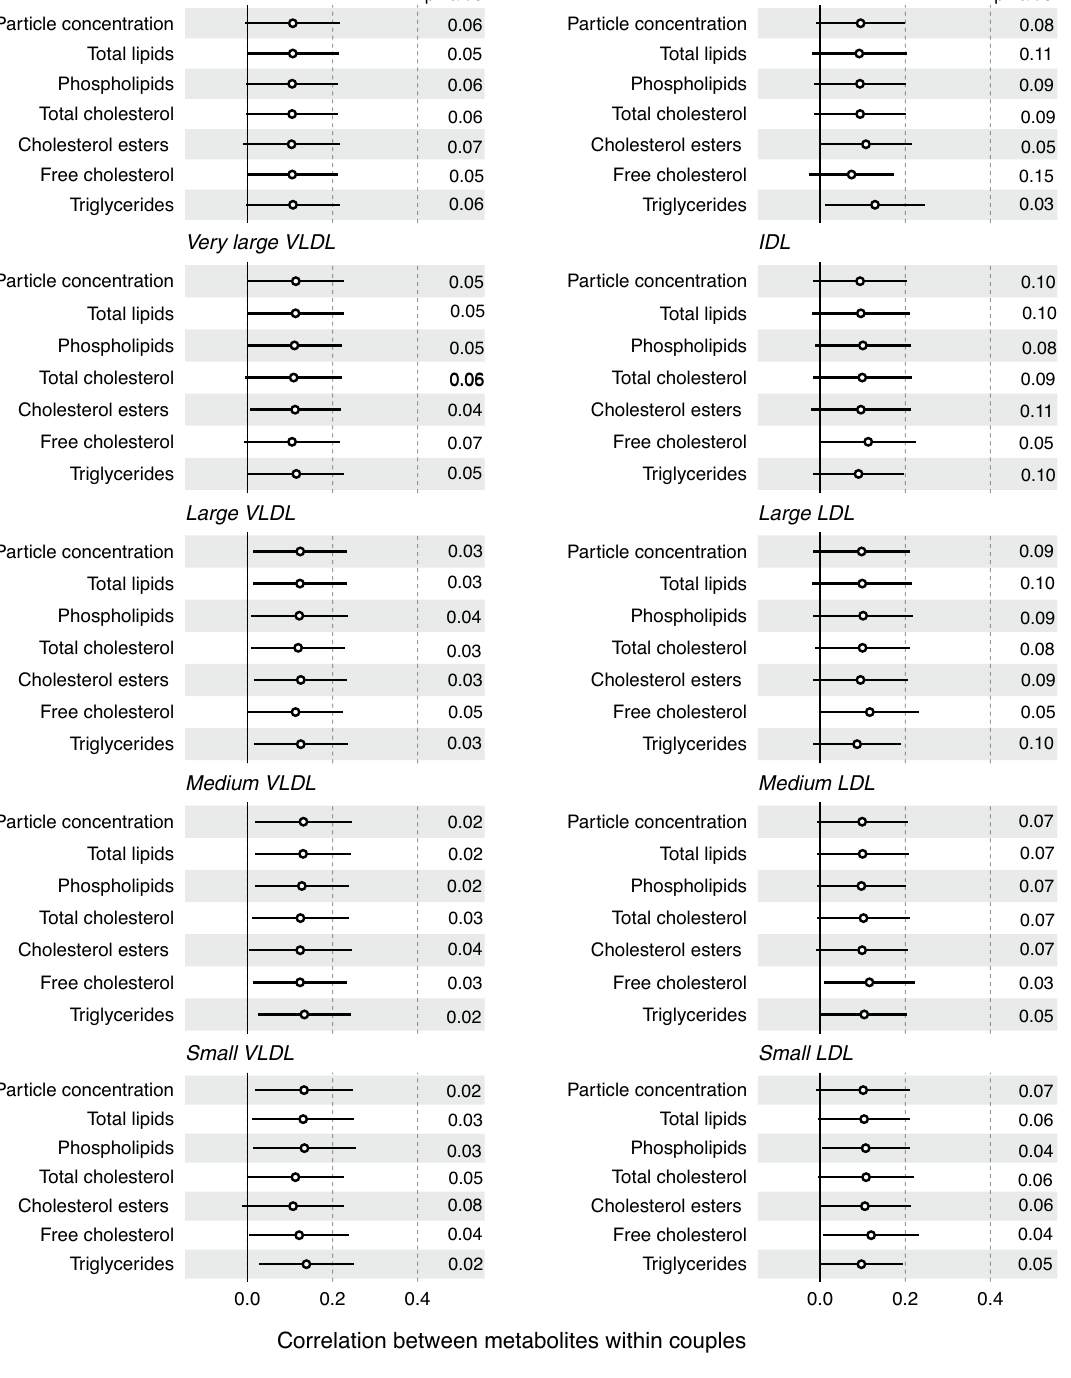
Figure 2. Correlations of lipoprotein classes, fatty acids and metabolic traits in couples awaiting IVF. Pearson correlation coefficients and 95% CI of within